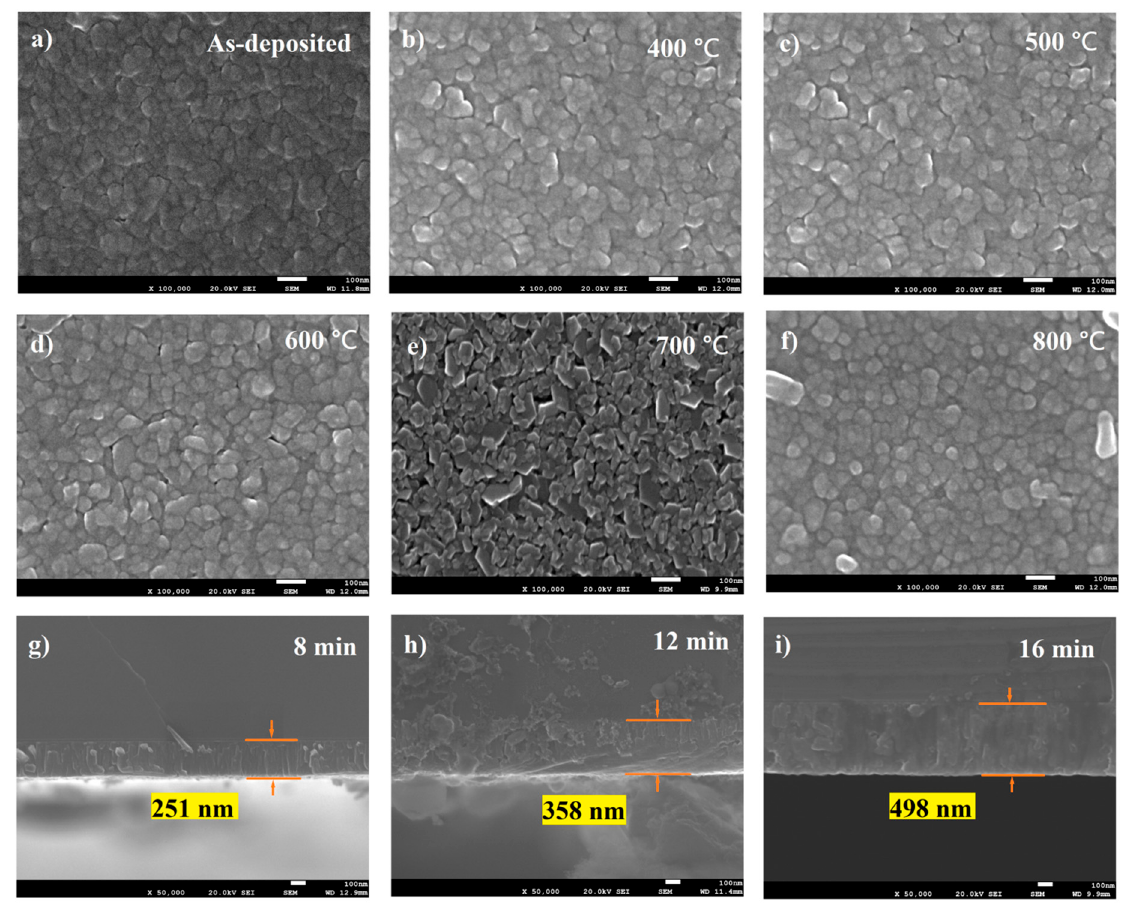
Figure 2. ( a – f ) SEM surface images of TiC thin films of before and after annealing with a thickness of 610 nm, ( g – i ) SEM cross-section images of TiC thin films at different sputtering times with Ti/C ratio of 0.74 and annealing at 800 °C.